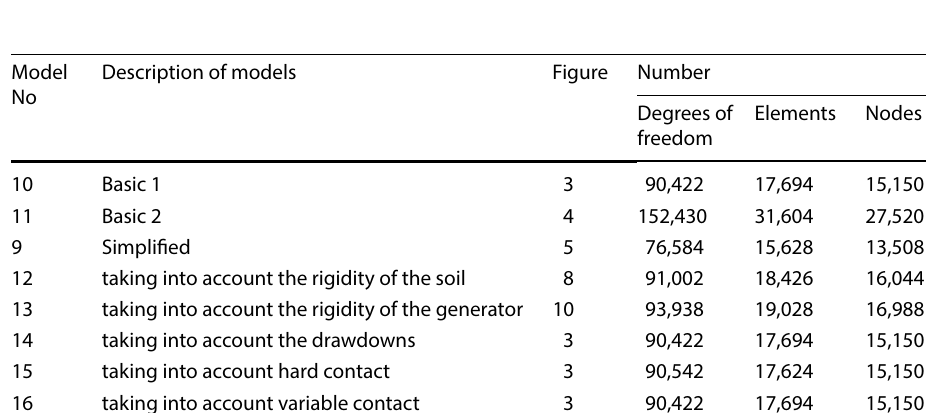
Model Description of models Figure Number No